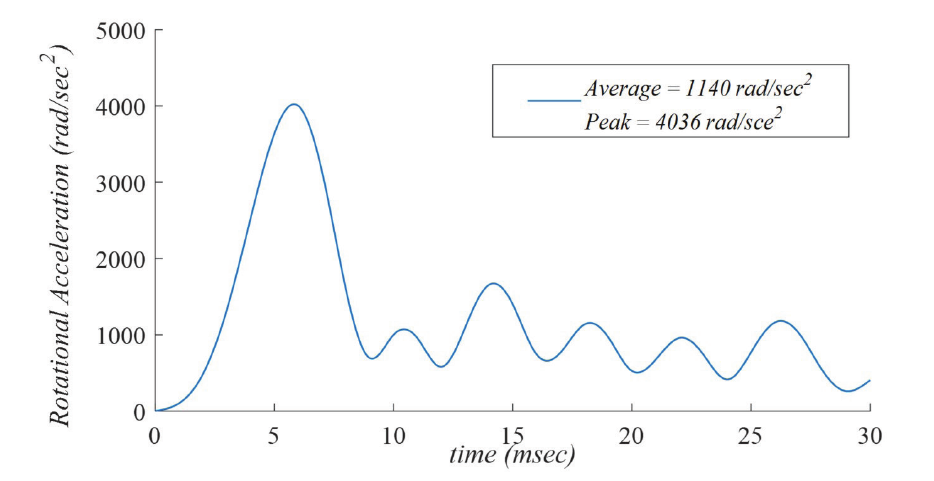
FIGURE 2. Head Rotational Acceleration vs